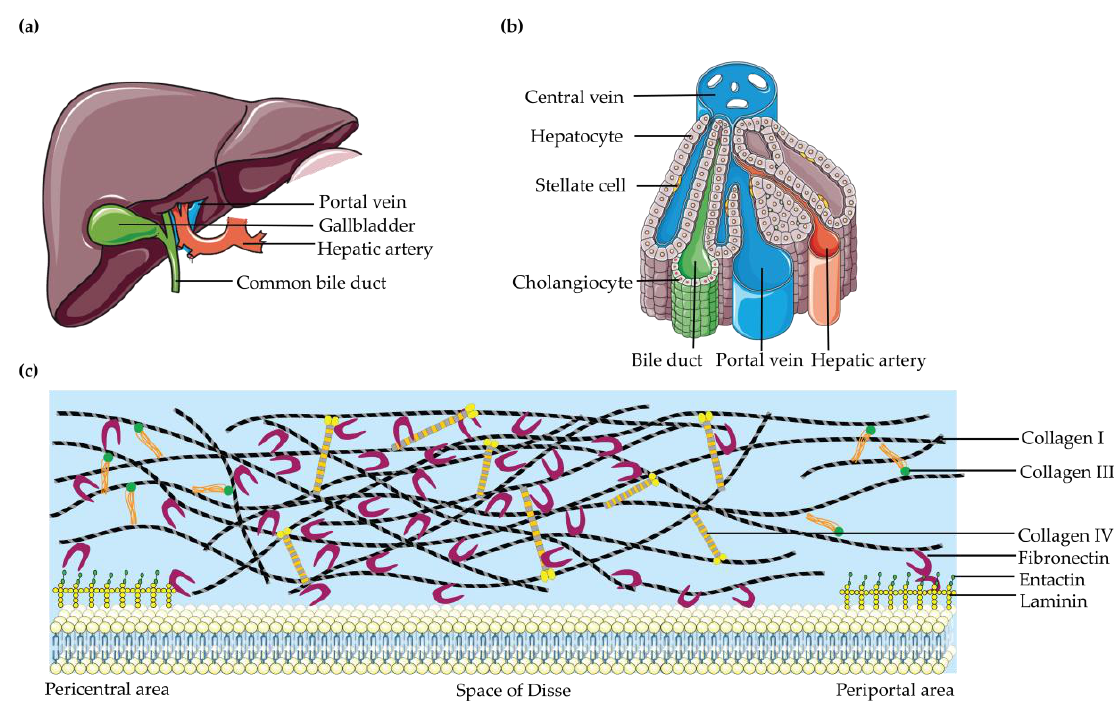
Figure 1. Liver histology and extracellular matrix (ECM). ( a ) A schematic representation of the whole human liver; ( b ) Schematic overview of the liver lobule; ( c ) The connection among major liver ECM components seen within the space of Disse.